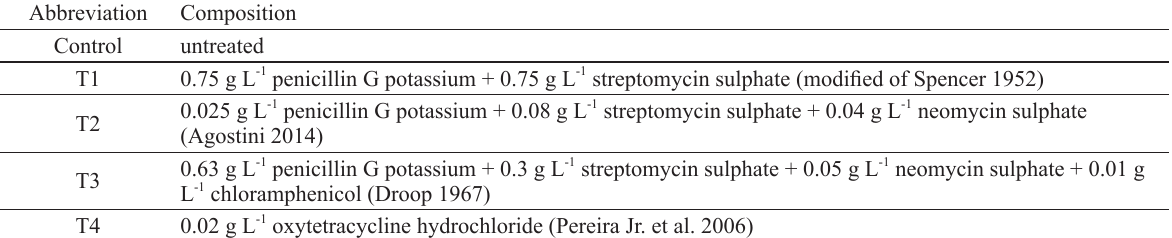
summary of all combinations tested in each treatment